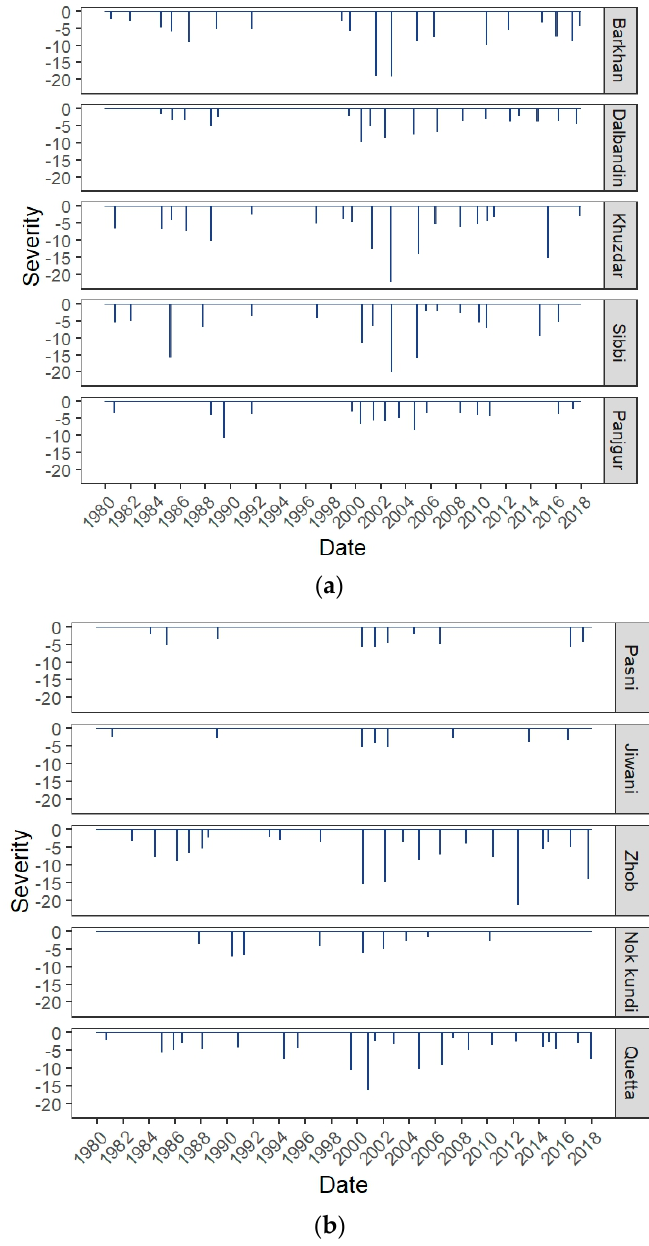
Figure 13. Drought severity at all stations.